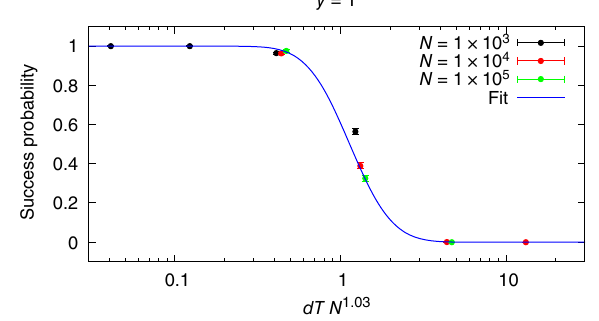
FIG. 11. As in Fig. 10, but for c ¼ 20 and running SA. Again the scaling dTN a with a ≈ 1 is very good, although the smaller errors suggest the presence of finite-size corrections to scaling.